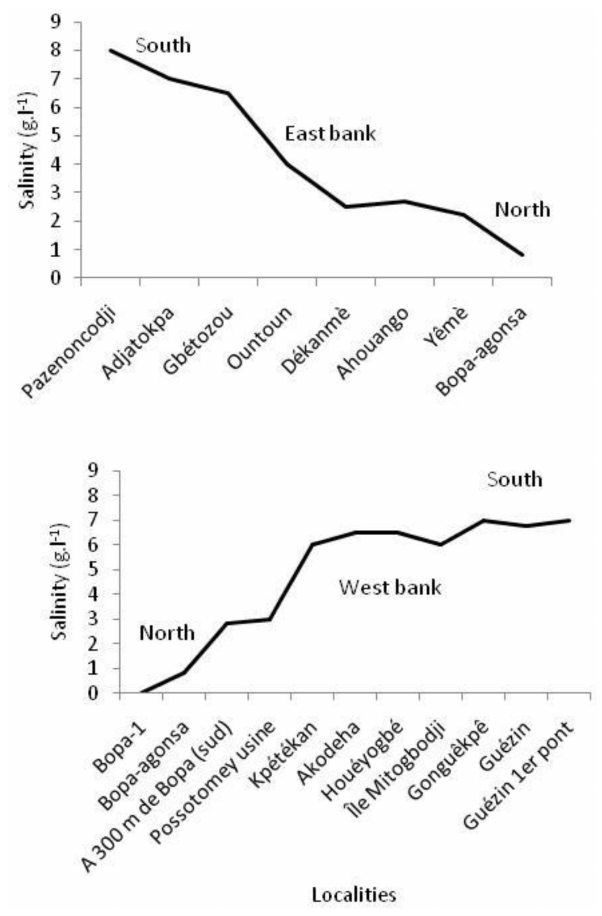
Figure 5. Spatial variation in salinity from South to North on the eastern and western bank of Ahémé lake in September 2002 (Source: Amoussou, 2003).